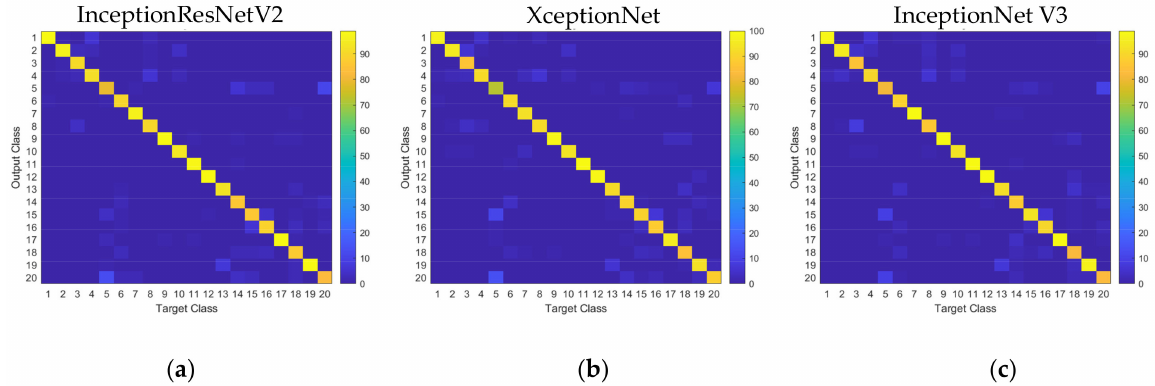
Figure 21. Confusion matrices obtained from ( a ) InceptionResNetV2 ( b ) XceptionNet ( c ) InceptionNetV3.